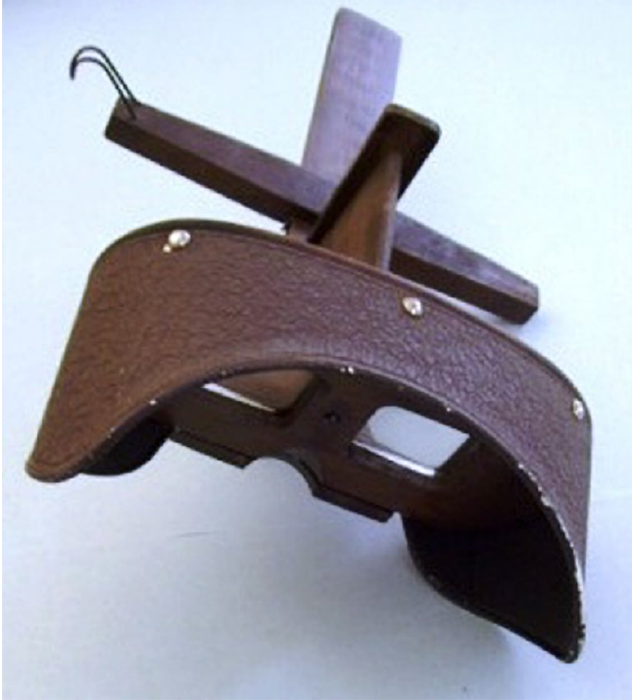
Figure 1 A stereoscope from the collections of the Alabama Museum of the Health Sciences